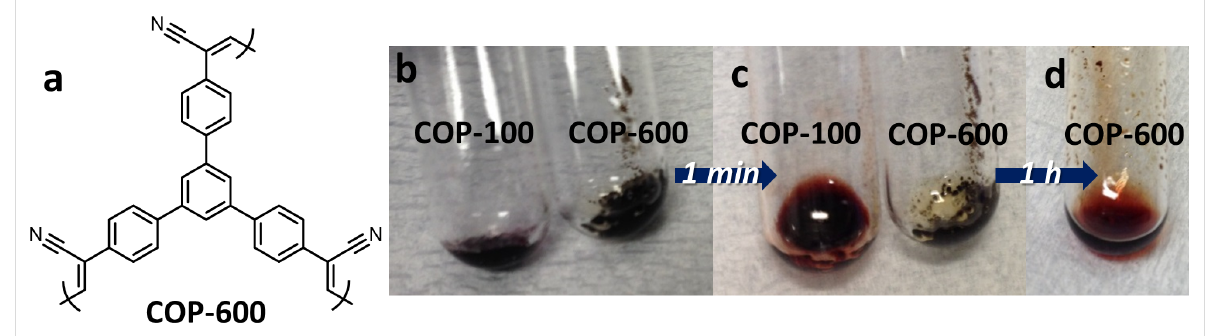
Figure 5: (a) Structure of COP-600 synthesized by Knoevenagel-like condensation. Solubility of COP-600 in EDA compared to COP-100; (b) addition of EDA at r.t., (c) heat treatment at 100 °C for 1 min and (d) for 1 h.